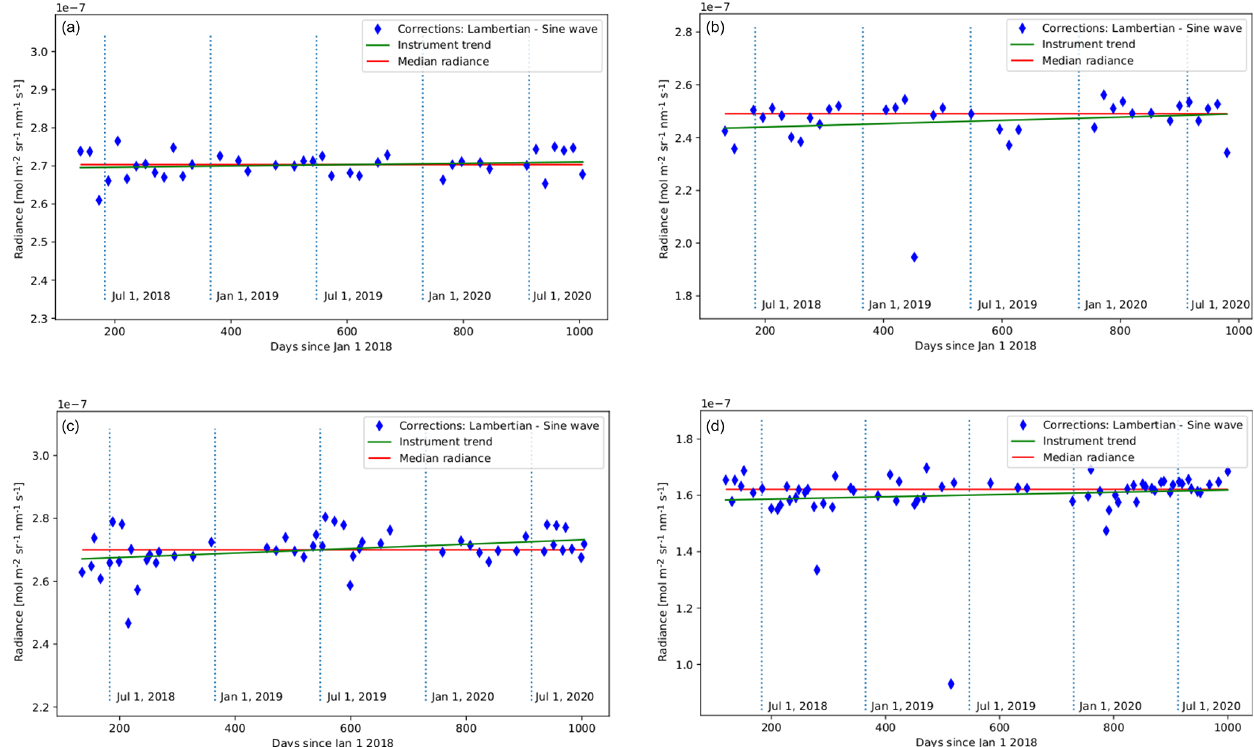
Figure 5. Comparison of the relative standard deviation of the time series of radiance with the site homogeneity at 20km (SHOM) given in Bacour et al. (2019), revealing a lack of